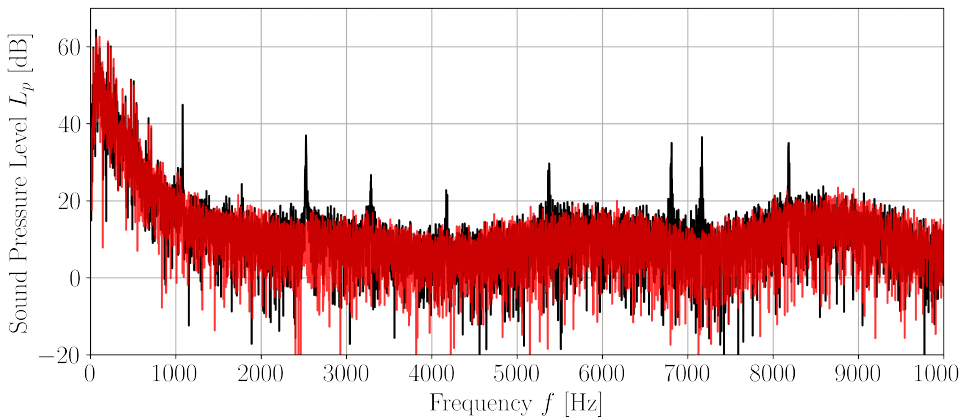
Figure 14. Sound pressure level of cavity noise with flexible steel walls ( ) and stiff walls (